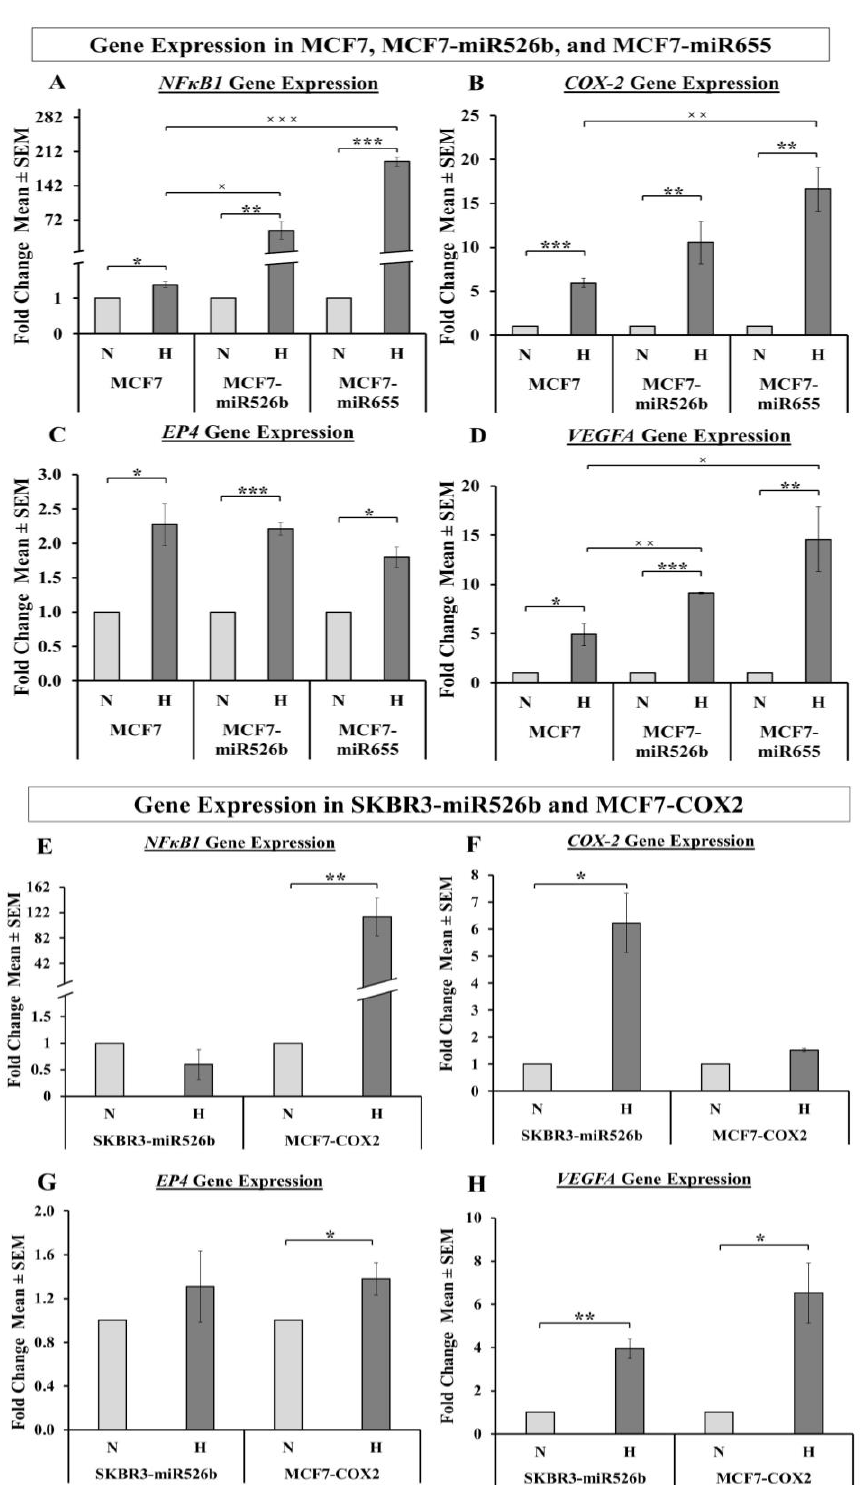
Figure 6. NF κ B1 , COX-2 , EP4 , and VEGFA gene expression: ‘N’ indicates normoxia, and ‘H’ indicates hypoxia. ( A ) NF κ B1 , ( B ) COX-2 , ( C ) EP4 , and ( D ) VEGFA represents gene expression in MCF7, MCF7-miR526b, and MCF7-miR655 cell lines. ( E ) NF κ B1 , ( F ) COX-2 , ( G ) EP4 , and ( H ) VEGFA gene expression in SKBR3-miR526b and MCF7-COX2 cell lines. Data are presented as the mean ± SEM of quadruplicate replicates; * p < 0.05, ** p < 0.01 and *** p < 0.001. x indicates p < 0.05, xx indicates p < 0.01 and xxx indicates p < 0.001. * Also indicates comparison between normoxia and hypoxia of the same cell line and x indicates comparison between cell lines only in hypoxia.